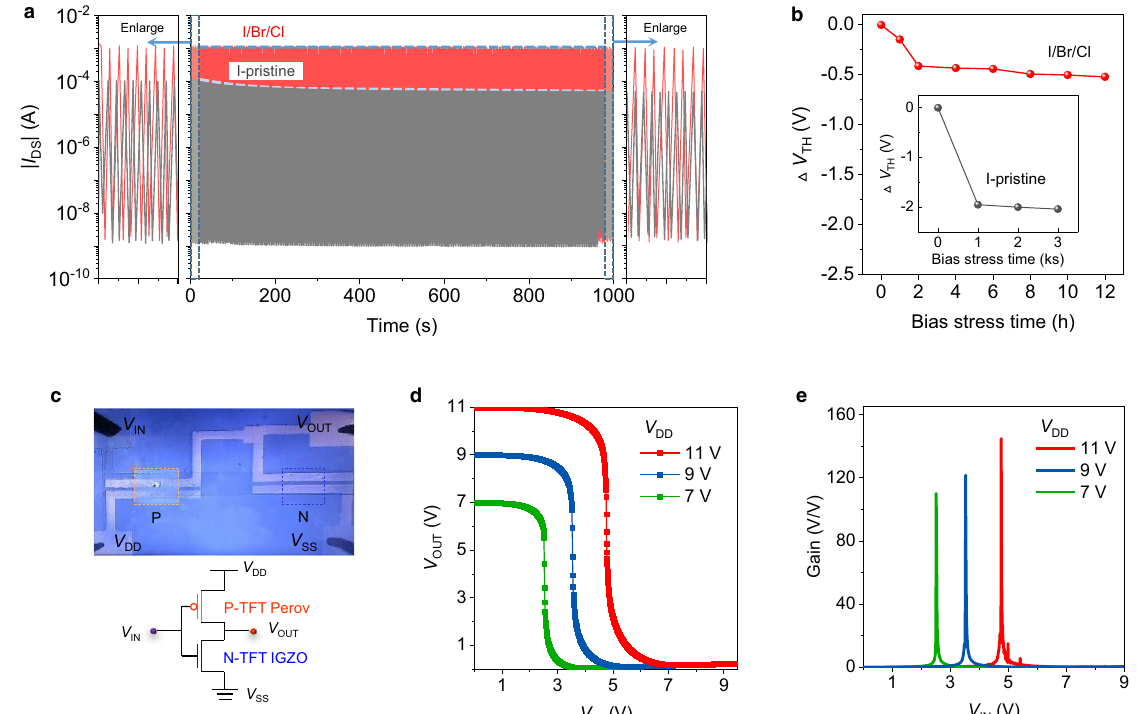
Fig. 4 Operational stability of perovskite TFTs and performance of the integrated inverters. a On/off switching sweep of the I-pristine and I/Br/Cl TFTs. b V TH variation under bias ( V GS = V DS = − 12 V). c Optical image and diagram of an integrated perovskite/IGZO inverter. d Voltage transfer characteristics and e gain ((d V OUT )/(d V IN